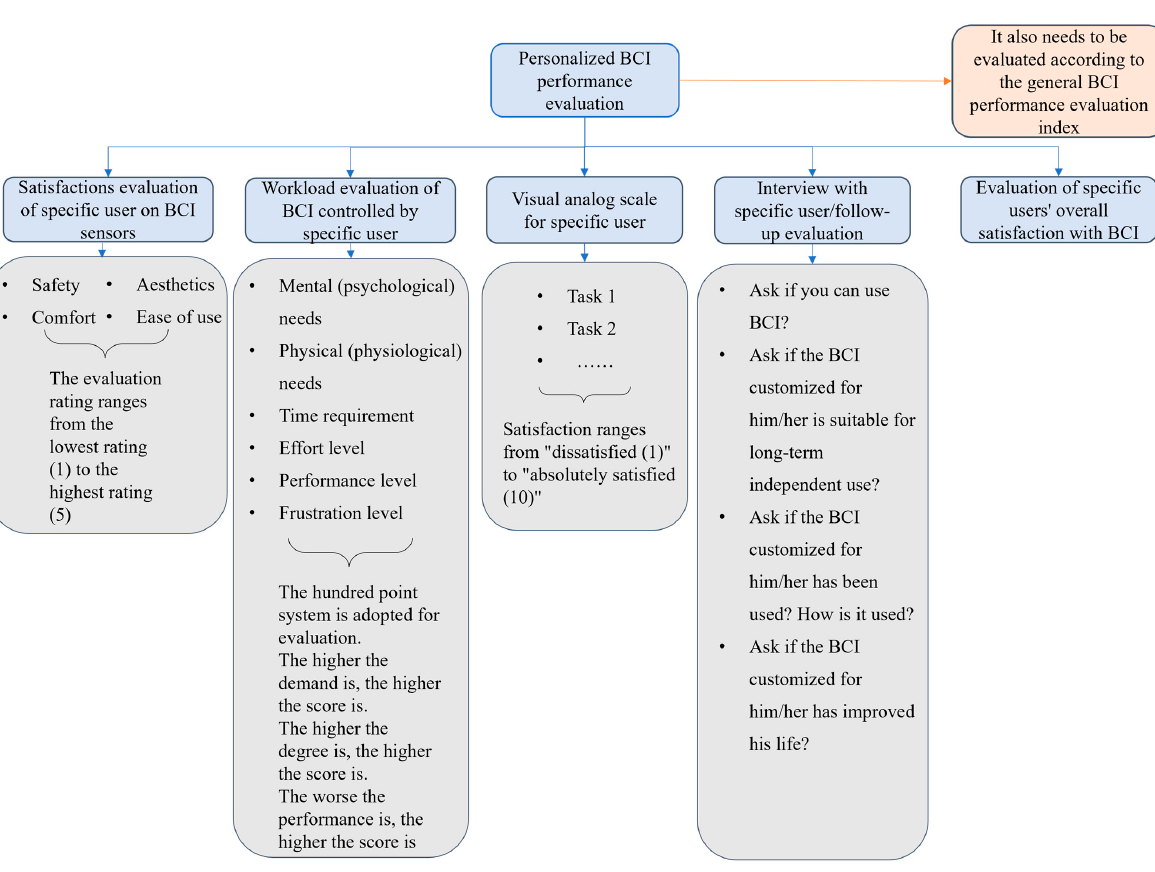
Figure 4. Evaluation method of personalized BCI performance. The general BCI performance evaluation index comes from Table 2.